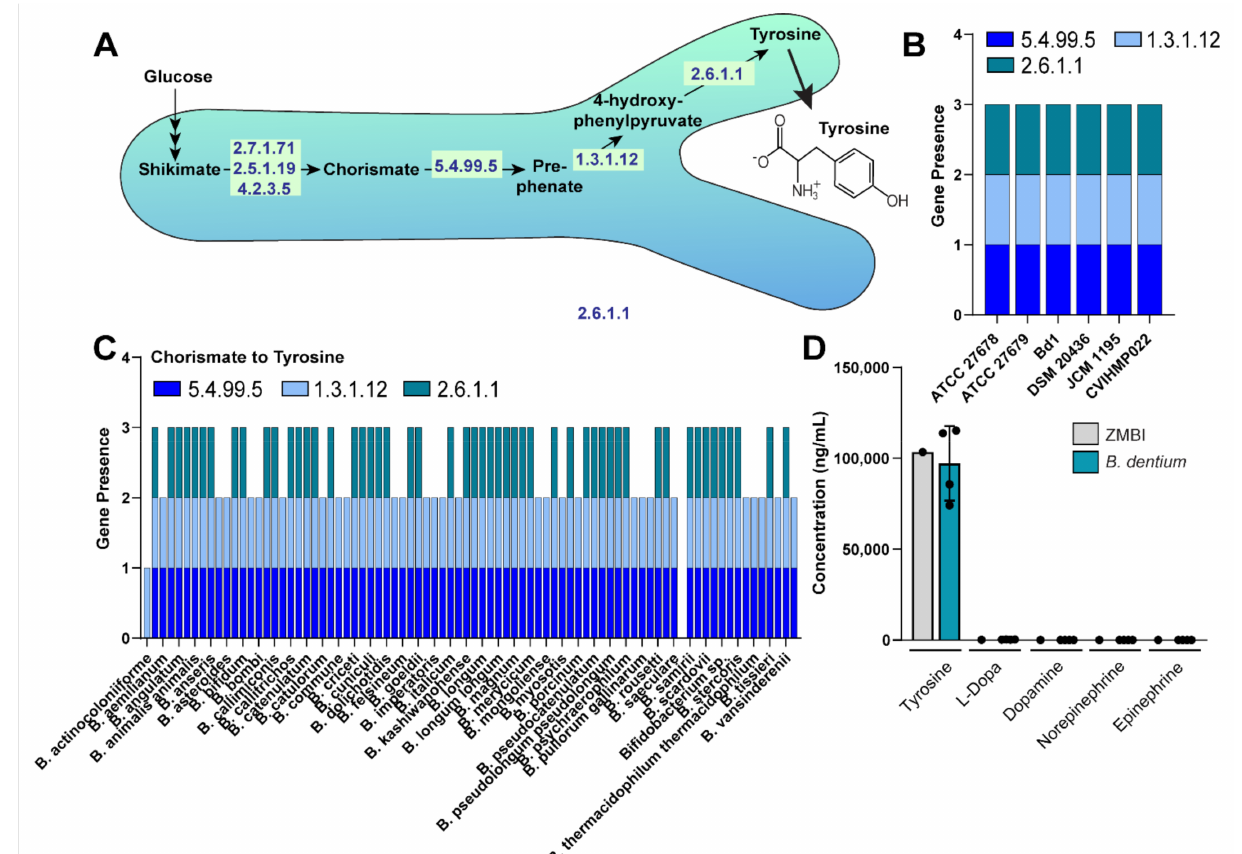
Figure 3. ( A ). Gene pathways in B. dentium as identified via KEGG (https://www.genome.jp/kegg/kegg2.html) related to tyrosine production. ( B ). Genome analysis of the JGI Integrated Microbial Genomes (IMG) database (http://img.jgi.doe.gov (accessed on 17 January 2021)) of six B. dentium genomes for the enzymes (Enzyme Commission, ECs) involved in tyrosine production. Data represent the number of copies for each EC gene. ( C ). Genome analysis of 83 Bifidobacteria genomes using the JGI Integrated Microbial Genomes (IMG) database. ( D ). Absolute concentrations of tyrosine, L-dopa, dopamine, norepinephrine, and epinephrine in uninoculated ZMB1 and cell-free bacterial conditioned ZMB1 from B. dentium after 18 h growth. n = 4 biological replicates, two-way